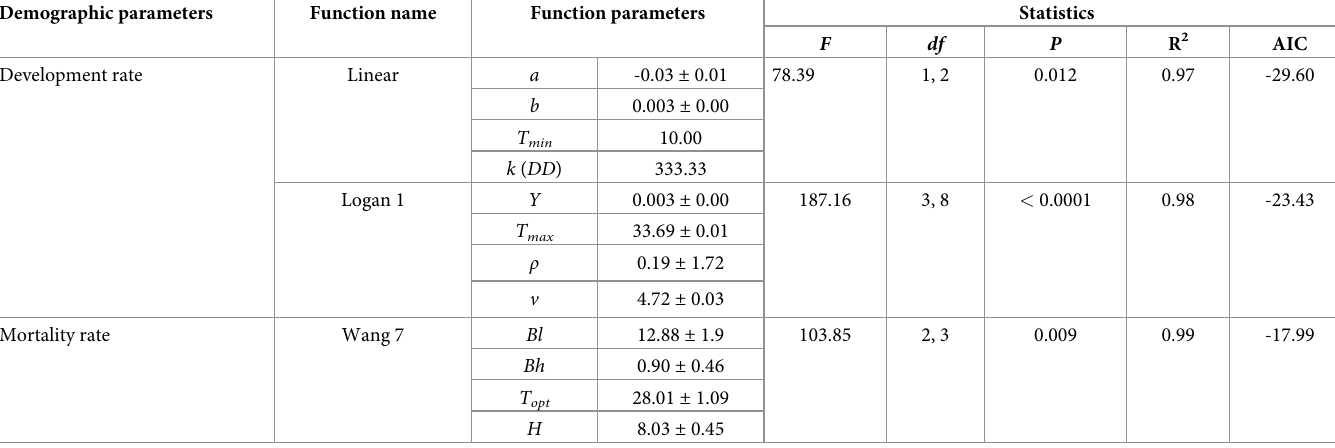
Table 2. Statistics of the goodness of fit and parameters of functions with their approximate standard errors fitted to describe the relationship between Diachasmi- morpha longicaudata development rate and mortality rate from egg to adult and